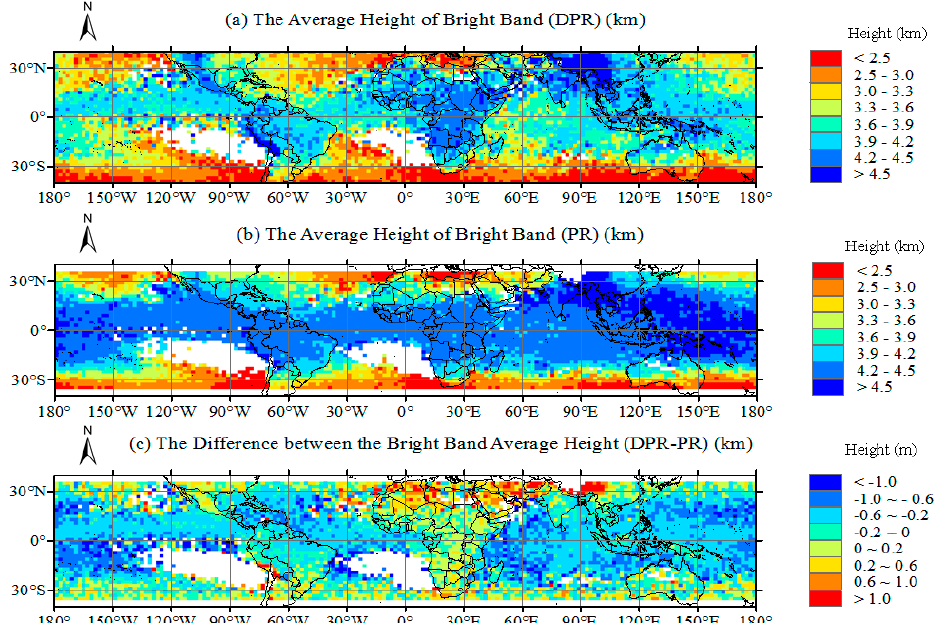
Figure 6. The distribution of the average height of bright band captured by: ( a ) GPM DPR; and ( b ) TRMM PR. The difference between the observations of the bright band height is shown in ( c ), calculated by GPM DPR’s observation minus TRMM PR’s. All data are resampled to a spatial resolution of 2° × 2°.